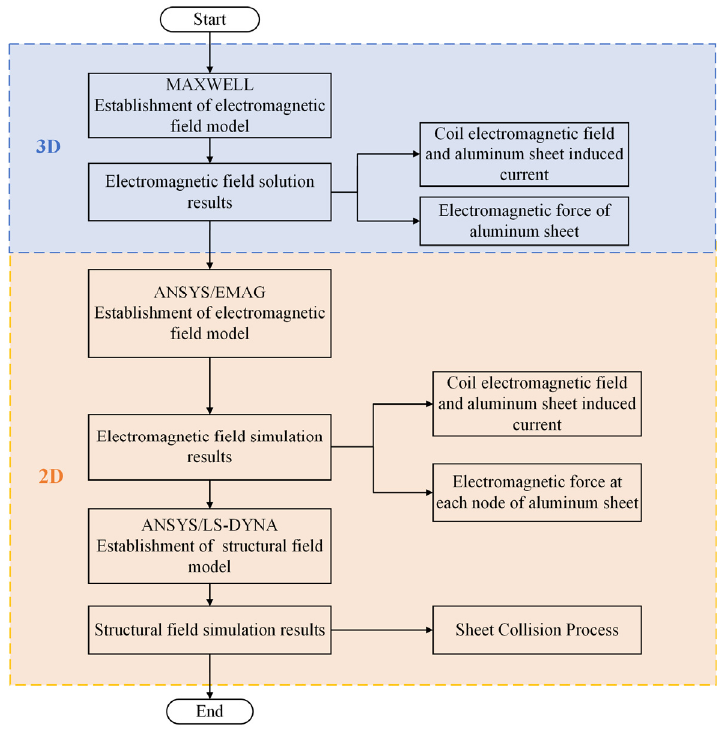
Figure 1. The principles of the MPW process.